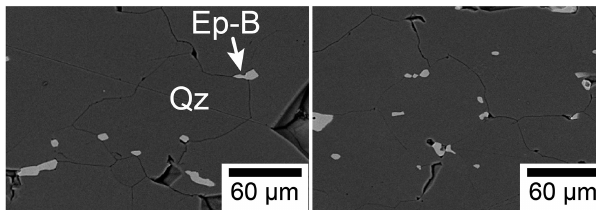
Figure 9. Backscattered electron images showing Epidote-B (Ep- B) grains along quartz (Qz) grain boundaries and at triple junctions among quartz